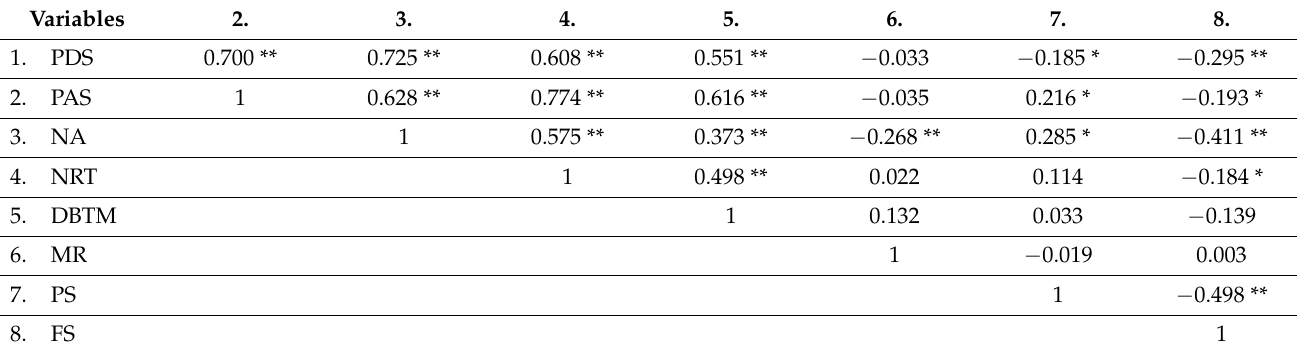
Table 3. Correlations of Postpartum Depression Screening Scale (PDSS) and Postpartum Anxious Screening Scale (PASS) scores and Negative Affect (NA), Negative Repetitive Thinking (NRT), Dys- functional Beliefs Towards Motherhood (DBTM), marital relationship (MR), and perception of part- ner’s support (PS) and family support (FS) for Group 2.